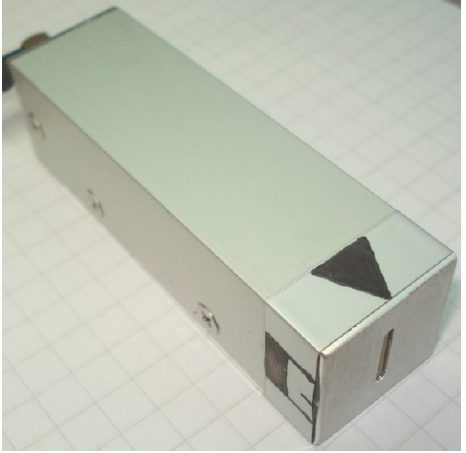
Figure 15. Air-coupled transducer for non-contact reception of evanescent waves.